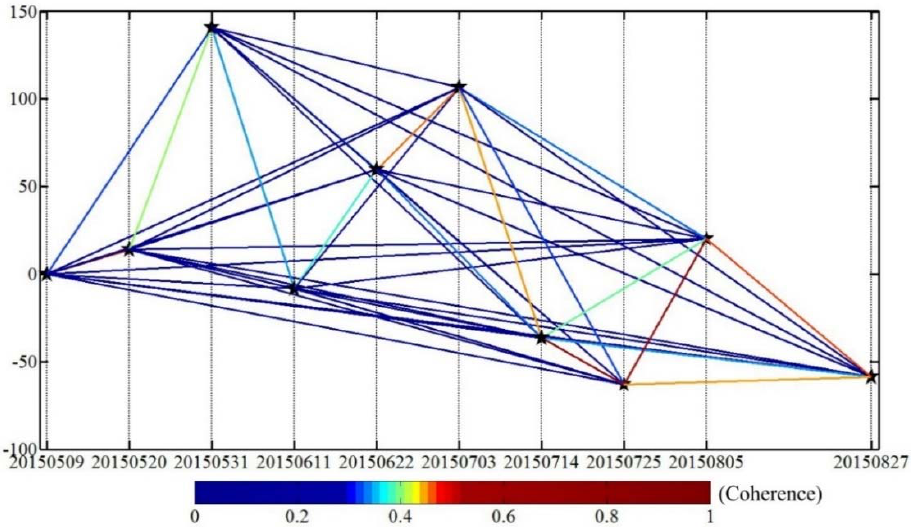
Figure 10. The temporal and perpendicular baselines of all the TSX interferometric pairs and their coherence (horizontal axis: the date of acquisition, vertical axis: the perpendicular baseline).